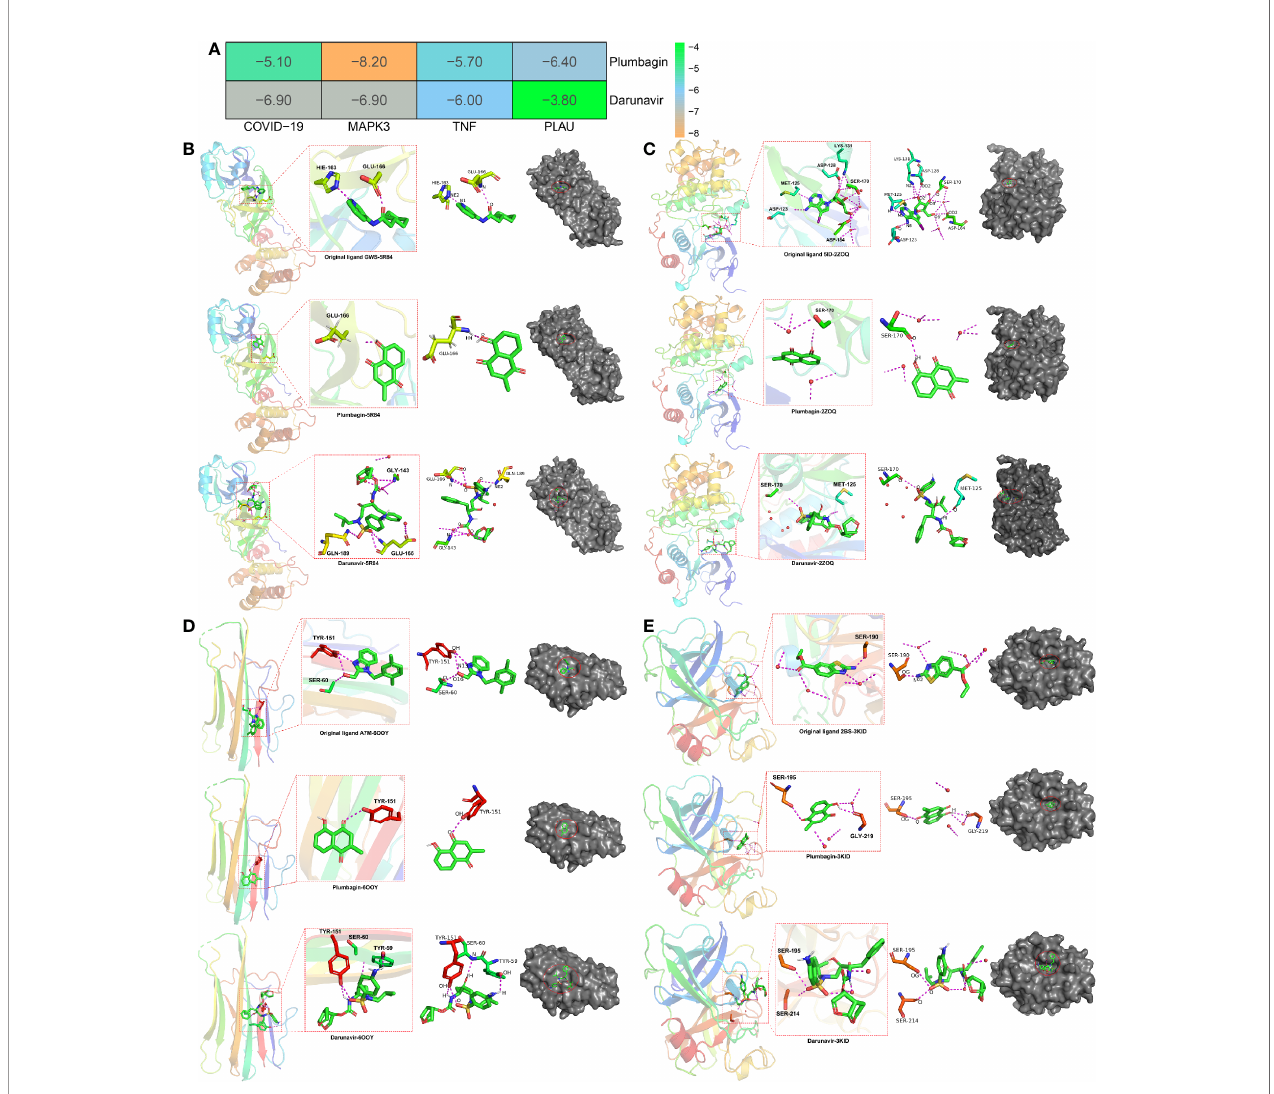
FIGURE 7 | Biological molecular docking fi ndings of PLB against UCEC/COVID-19. (A) , molecular af fi nity and the binding energy of PLB docked with core proteins, including MAPK3, TNF, and PLAU. (B – E) , in silico characteristics of PLB, docked with core